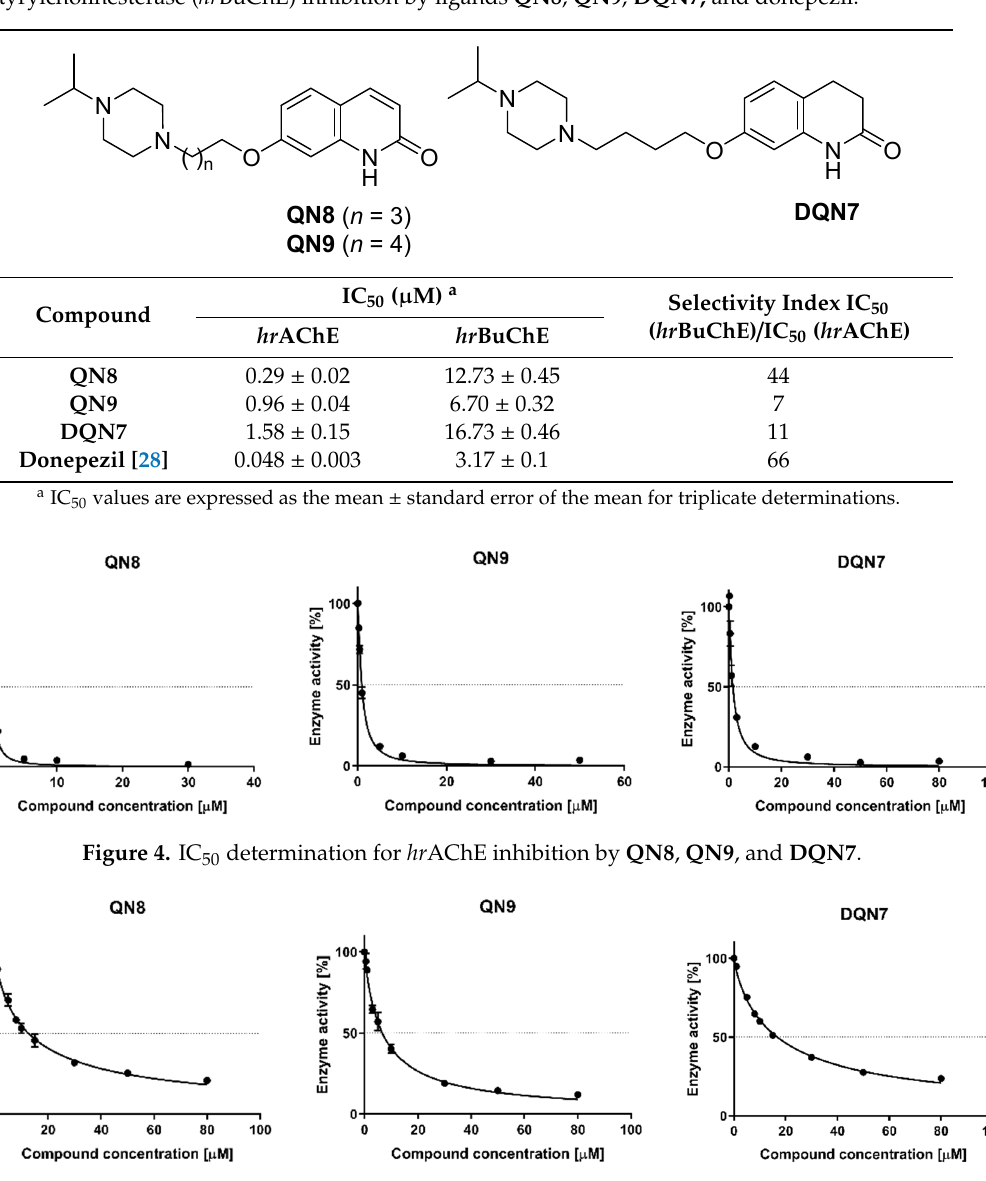
Figure 6. Inhibition kinetics of hr AChE by compound QN8 . Compounds DQN6 ‐ 8 and DQN10 ‐ 12 have been previously described and tested as MAO and ChE inhibitors [19]. We observed low hr MAO inhibition at 1 and 10 μ M concentration (data not shown) and did not determine their IC 50 . In a formerly published study [19], hr MAO inhibition was reported in the double digit micromolar range for most of the compounds, but the source of MAOs was not mentioned or referenced.